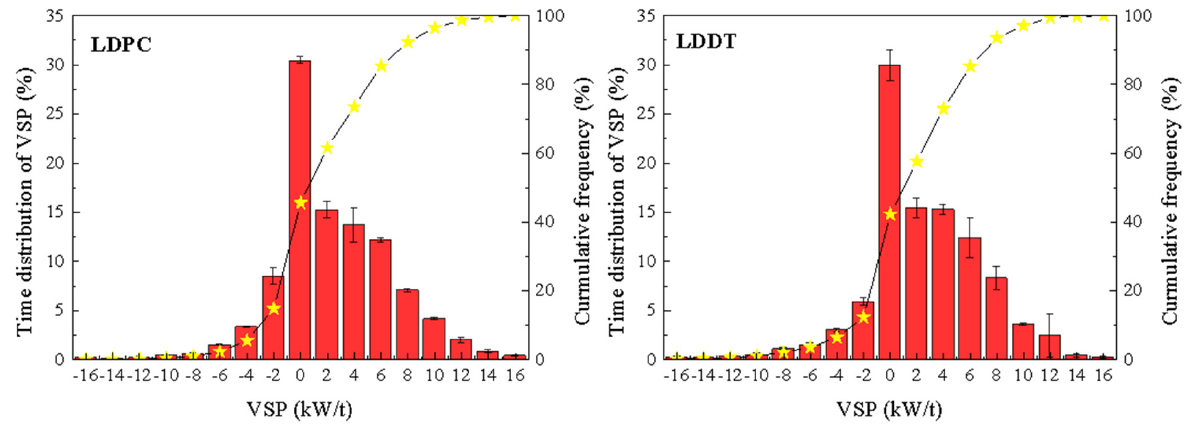
Figure 6. VSP distribution of typical vehicles (The abscissa in the figure is VSP Bin, and the ordinate is the time proportion and cumulative frequency of VSP interval).